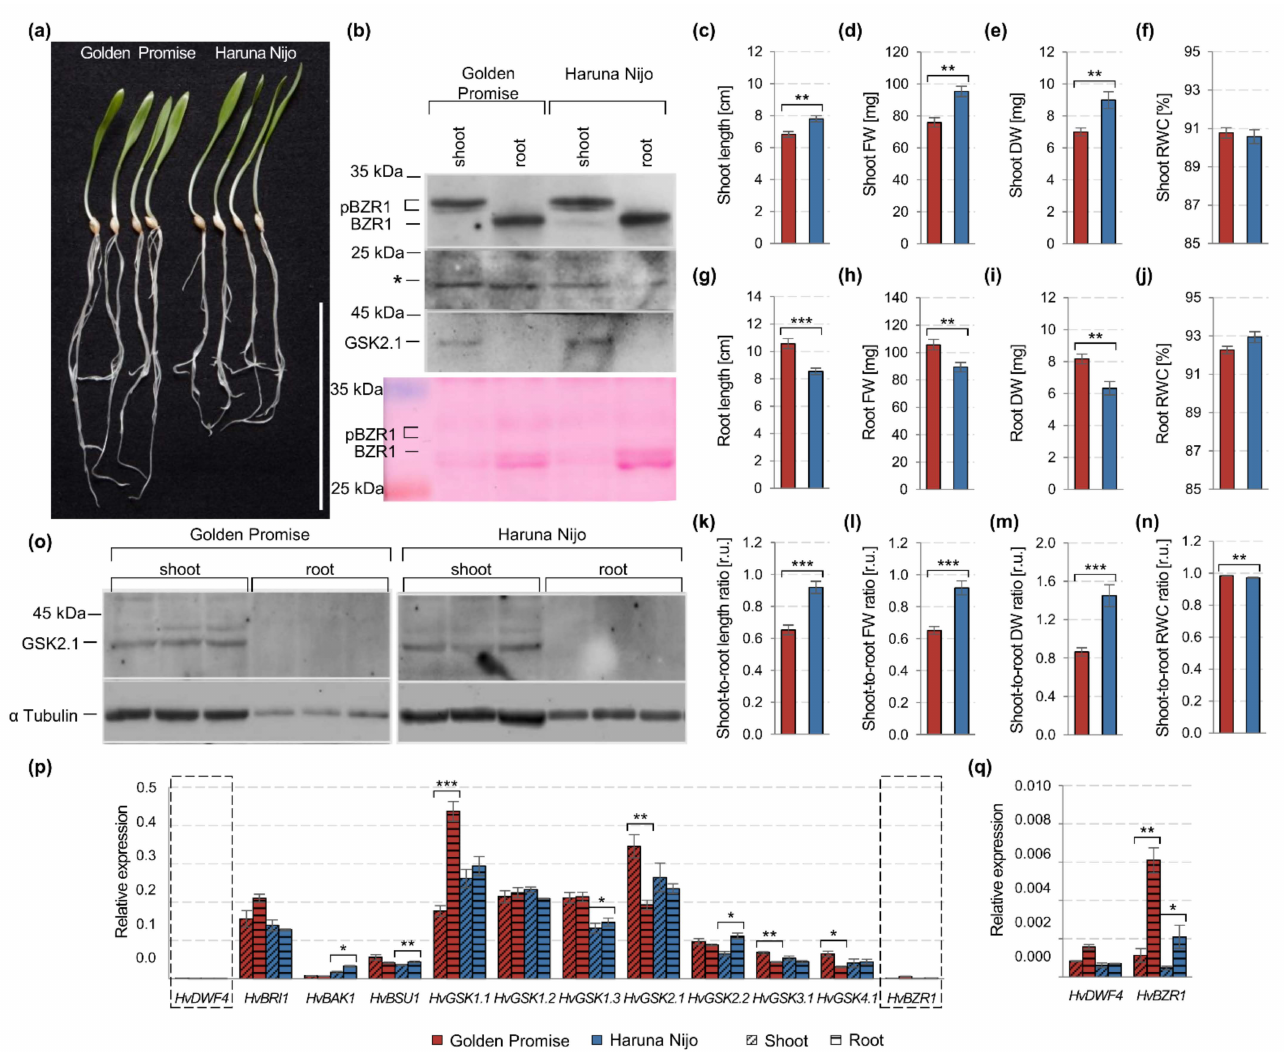
Figure 1. Phenotypic and molecular traits of 5-day-old shoots and roots measured for the Golden Promise and Haruna Nijo cultivars. ( a ) Representative example of plant phenotype in four biological replicates, scale bar = 10 cm; ( b ) immunodetection of Hv BZR1 and Hv GSK2.1, as well as a membrane staining of protein bands with a molecular weight in range from 25 to 35 kDa using the Ponceau S; * indicates a nonspecific product detected by the anti- Os BZR1 antibody; pBZR1 indicates the phosphorylated Hv BZR1 forms; BZR1 indicates the dephosphorylated Hv BZR1 form; ( c – n ) parameters of shoot growth ( c – f ), root growth ( g – j ), and shoot-to-root ratio ( k – n ); ( o ) immunodetection of Hv GSK2.1 kinase and α -tubulin as a control; ( p , q ) expression profile of the genes related to the BR biosynthesis and signaling pathways. The results present the mean with a standard error of the mean (phenotypic traits n = 6, ( c – n ); expression profile n = 3, ( p , q ). The asterisks indicate significant differences, revealed by the Student’s t -test for p < 0.05 (*), p < 0.01 (**), and p < 0.001